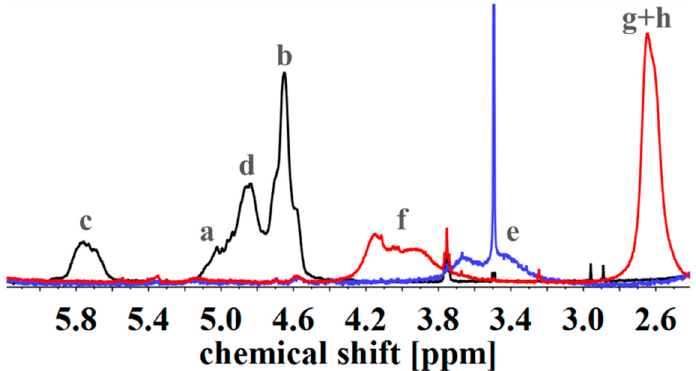
Figure 7. 1 H NMR spectra of unfunctionalized (black), hydroxylated (blue) and with SA carboxylated (red) I 5 S 90 I 5 62 in CDCl 3 . Spectra were normalized to aromatic protons of PS (6.2–7.2 ppm, 5H).